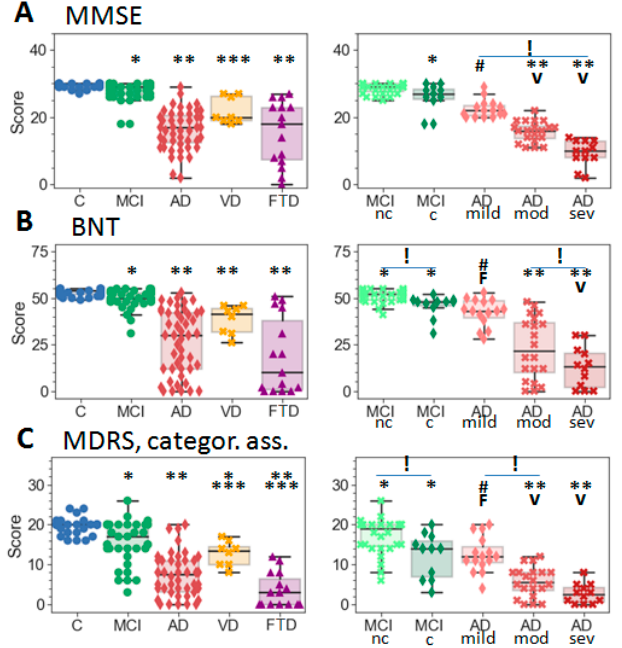
Figure 1. The results of study participants using psychometric tests and scales: ( A ) Mini Mental State Examination (MMSE), ( B ) Boston naming test (BNT), ( С ) Mattis dementia rating scale (MDRS) and categorical associations subtest. MCI—mild cognitive impairment (nc—non-converter, c— converter); AD—Alzheimer’s disease (mild, moderate, and severe subgroups); VD—vascular dementia and FTD—frontotemporal dementia. Lines inside the boxes show medians; box flanges— 25–75 percentiles; whisker range ± SD. Significantly different results, with p -values < 0.01 according to the Mann–Whitney U test, are shown with the following symbols: * significantly different to the control group; ** to the control and MCI groups; *** to the control, MCI and AD groups; **** to the control and AD groups; ***** to the control, MCI, AD and VD groups; # to the control and MCI-nc; “F”—to FTD; “V”—to VD; “!”—significant differences between subgroups. 2.2. Quantitative Analysis of Blood Plasma Proteins The analysis of the absolute concentrations of 125 proteins in samples from AD patients (47) and age-matched controls (43) revealed 97 proteins that were found in >70% of the samples (Supplementary Table S2). They included 72 previously identified potential AD markers, 17 of which were confirmed in ≥ three independent cohorts. A total of 22 proteins were found to be statistically different between the control and AD groups at an uncorrected p -value of < 0.05, including six proteins with p ≤ 0.01 (Figure 2). These proteins included 15 earlier proposed CBs of AD (Supplementary Table S2), 6 of which were reproduced in ≥ three independent cohorts: afamin, APOE, APOA4, FGG, fibronectin and vitronectin. However, only afamin passed the 5% FDR cutoff, and biotinidase, APOE and PON1 passed the 10% cutoff after Benjamini–Hochberg multiple test correction. The estimation of Cohen’s d values suggests that these four proteins represent a higher than medium effect size, which is important for distinguishing the control group, while the level of C1QB appears to be the most important for distinguishing AD (Figure 3A). Nevertheless, these differences are not enough to serve as a basis for a reliable distinguishing method development; thus, all further 97 quantified proteins were considered as features for the analysis and building of a machine learning approach.